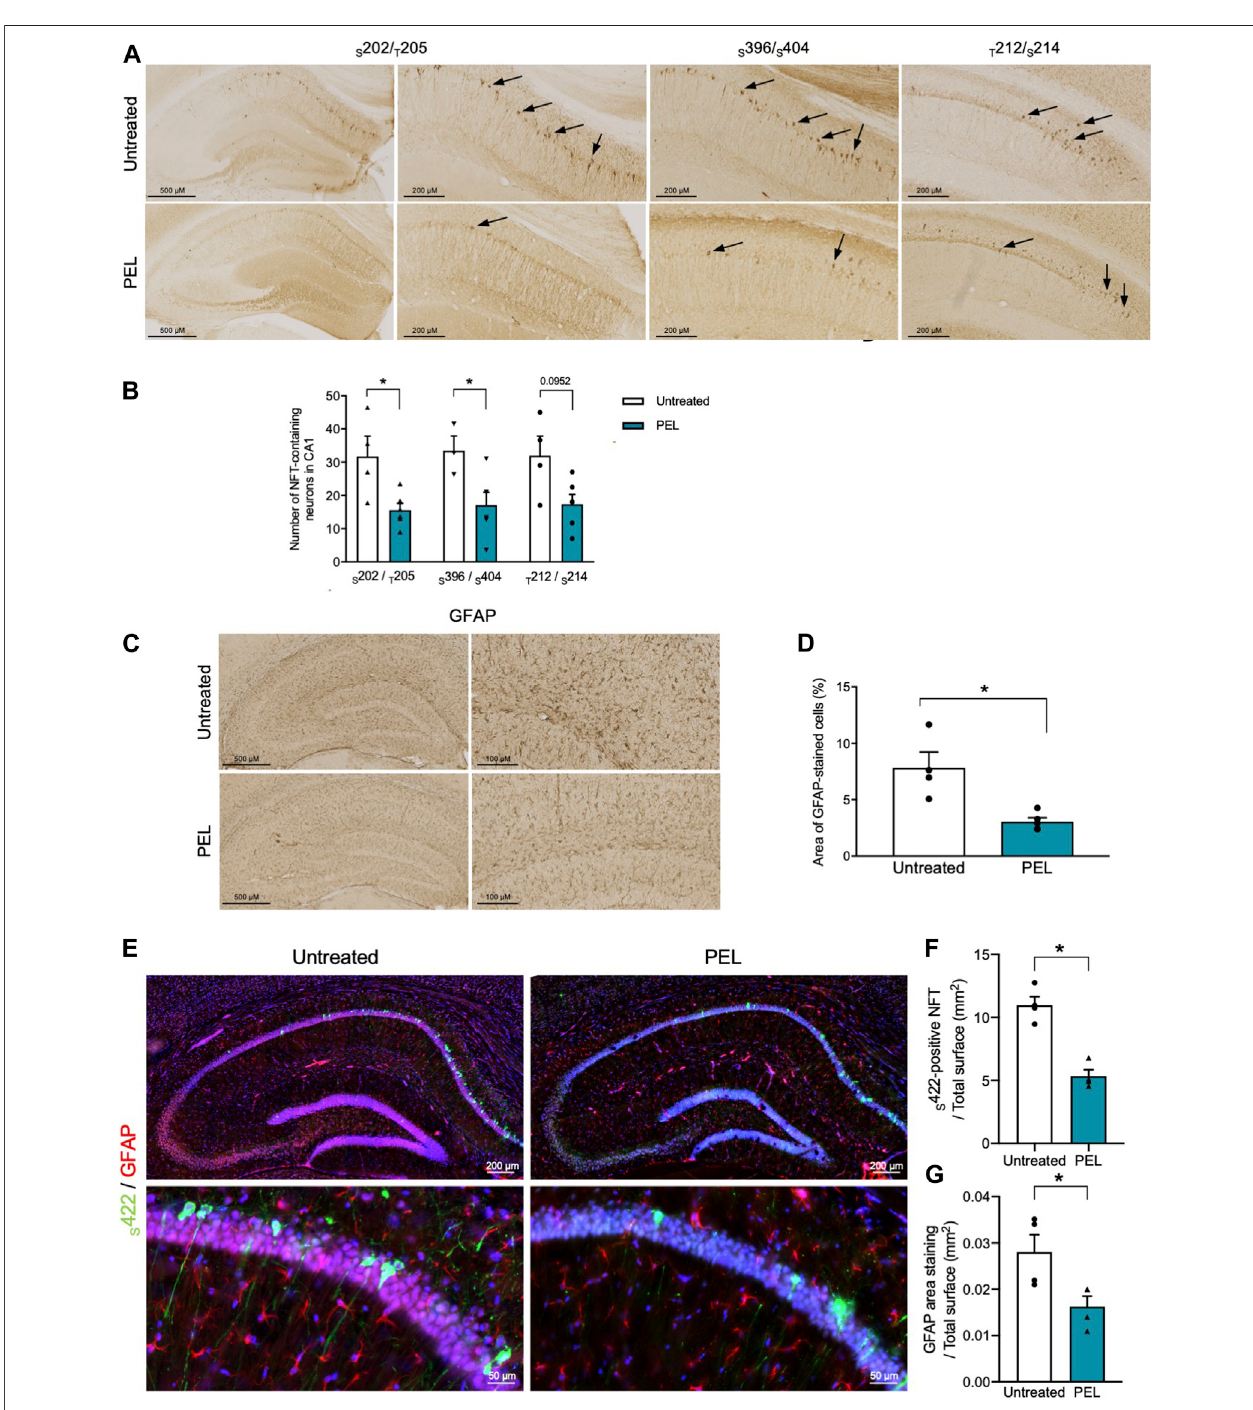
FIGURE 4 | Tau pathology and astrogliosis are reduced in PEL24-199 THY-Tau22 – treated animals. (A) Immunohistochemistry with the phospho-Tau antibodies against phospho-epitopes S 202/ T 205 and S 396/ S 404 or pathological epitopes ( T 212/ S 214) in the hippocampus of THY-Tau22 animals treated or not with PEL24-199 (PEL). (B) The mean ± SEM number of NFT-labeled neurons observed in three brain slices per animal ( n (cid:1) 4 animals per condition) are represented on the histogram. Labeled neurons with the S 202/ T 205, S 396/ S 404, and T 212/ S 214 were counted in the hippocampus of untreated (uncolored bars) and PEL24 – 199 – treated (blue bars) animals. Statistical differences between untreated and treated conditions were signi fi cant with a p -value below 0.05 (*). (C) Reactive astrocytes were labeled with glial fi brillary acidic antibody (GFAP) in sections of the hippocampus of untreated and PEL24-199 (PEL) – treated THY-Tau22 mice. (D) Histogram representation of the mean ± SEM ratio of GFAP labeling upon the total hippocampal surface in mm 2 (three individual hippocampal sections per animal and a minimum of four animals per condition). Statistical differences between untreated and treated conditions were signi fi cant with a p -value below 0.05 (*). (E) Immuno fl uorescence analysis of S 422-